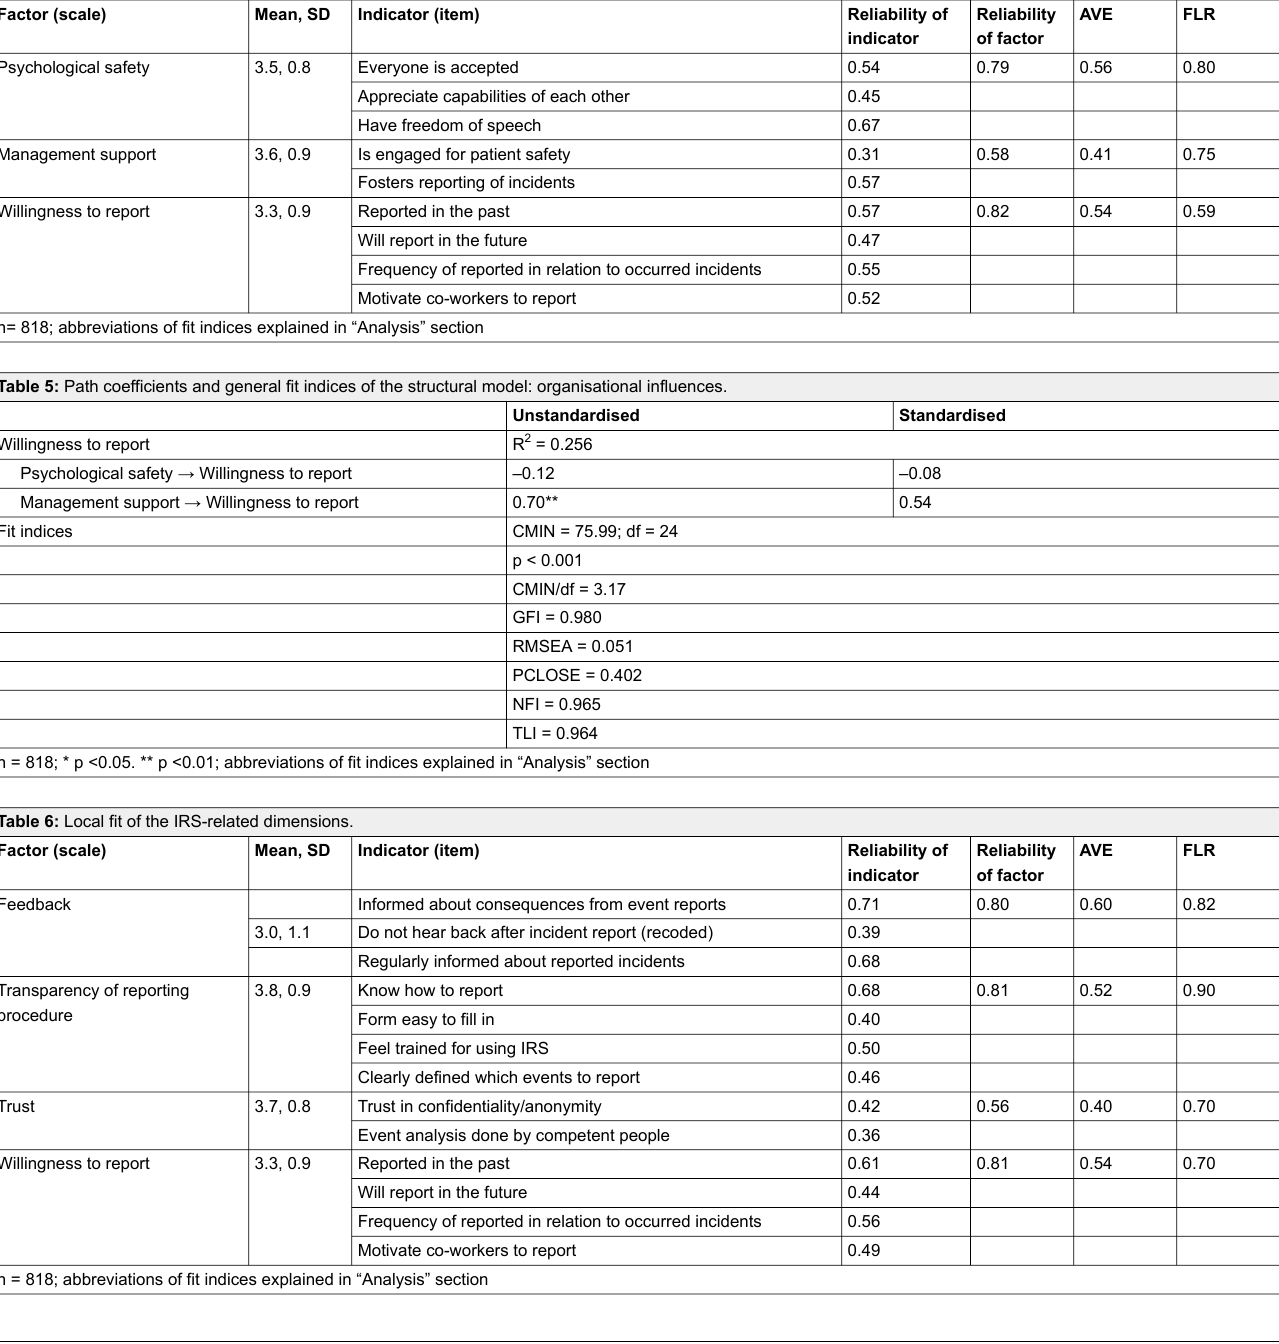
Table 4: Local fit of the organisational dimensions. Factor (scale)